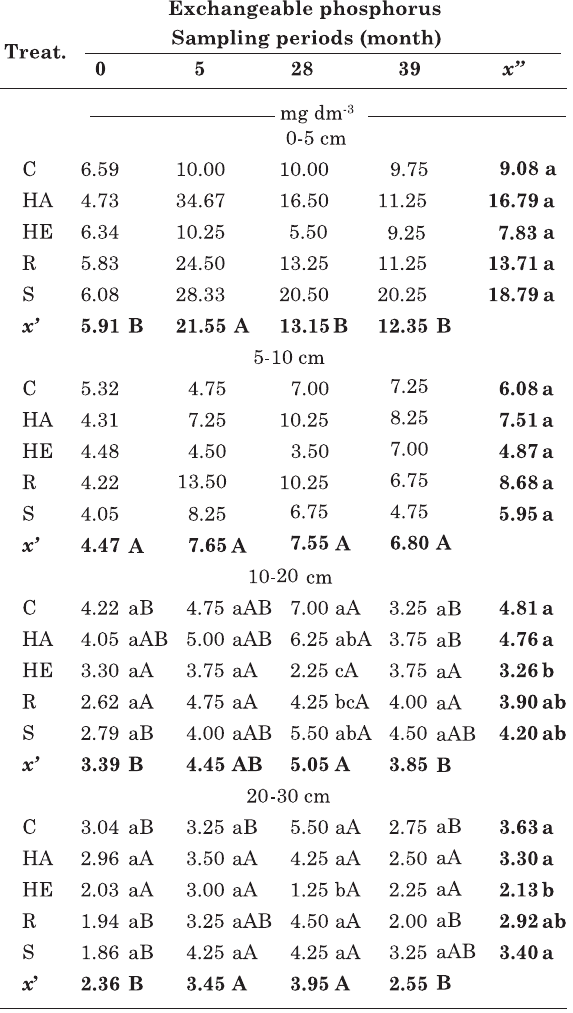
Table 4. Soil exchangeable phosphorus in pasture recovery treatments in four sampling